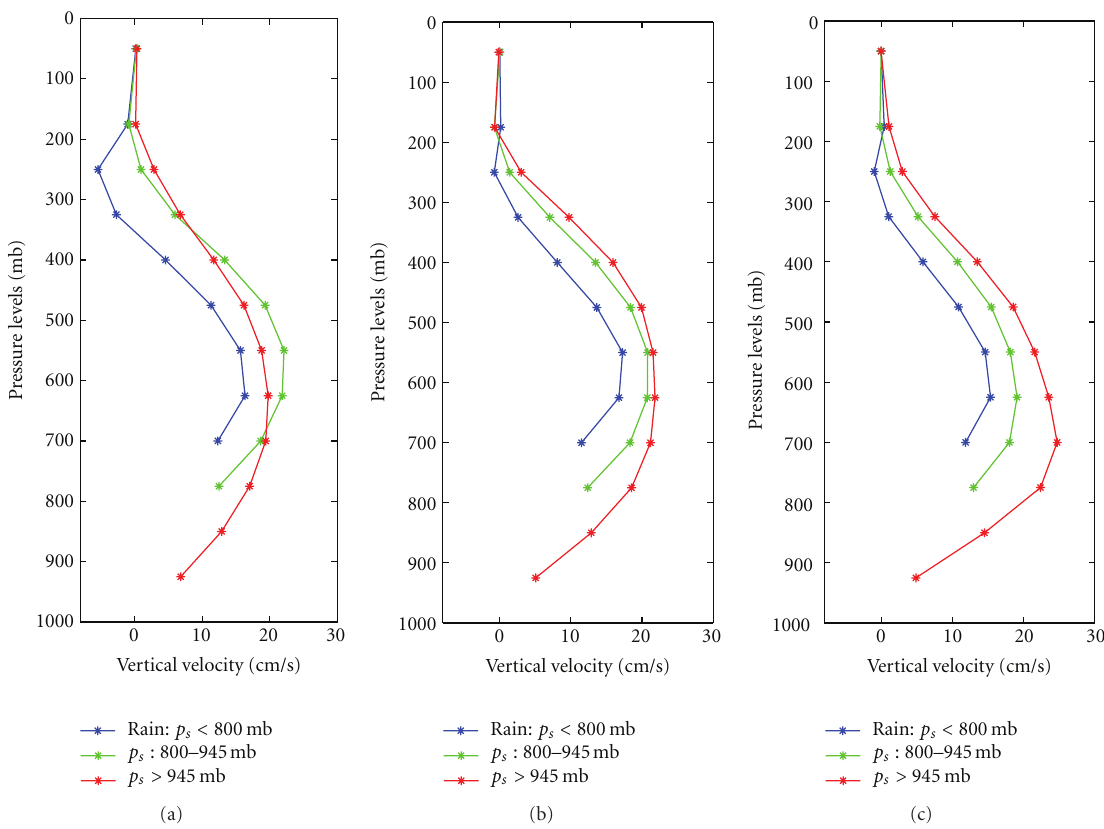
Figure 10: The averaged vertical profiles of vertical velocity (in cm/s) deduced from (a) 12km runs, (b) 6km runs with cumulus parameterization turned on, and (c) 3km